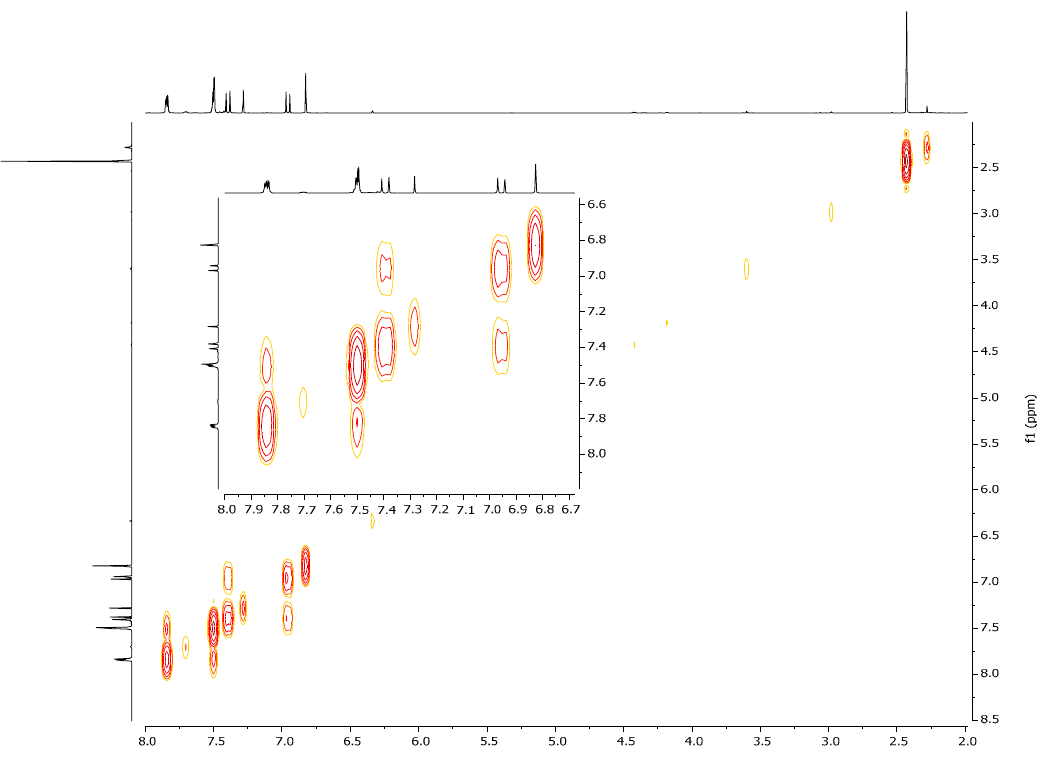
Figure 1. Data of 1 H- 1 H correlation spectroscopy for compound (E)- 4c (CDCl 3 ).